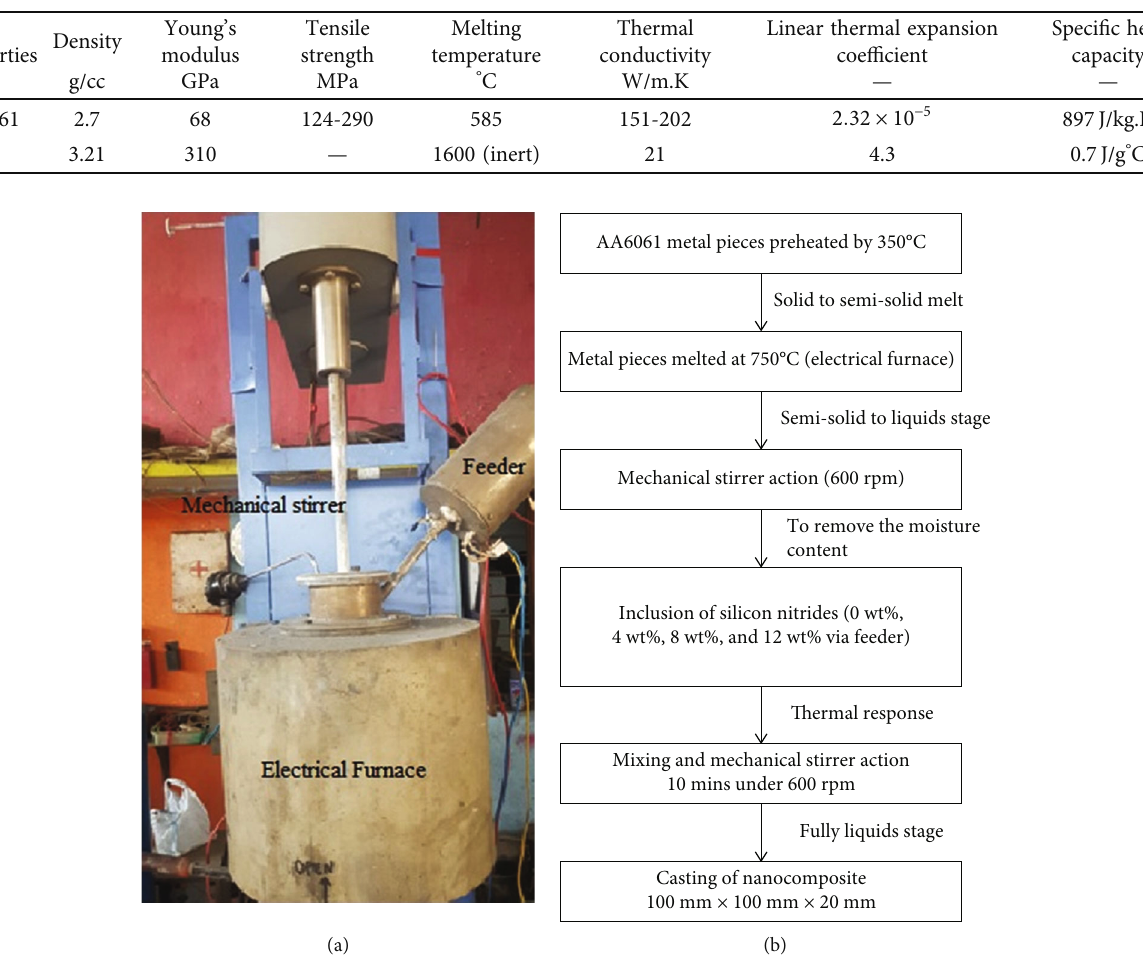
Figure 1: Aluminium-melting furnace (a) actual fabrication setup and (b) fl ow process chart for AA6061 alloy nanocomposites. Table 3: Weight percentages of matrix and reinforcements.